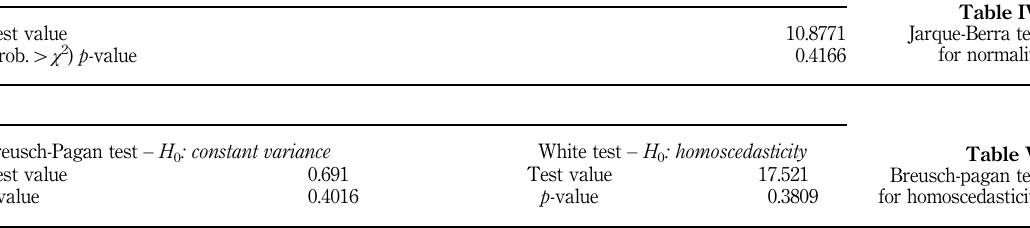
Table IV. Jarque-Berra test